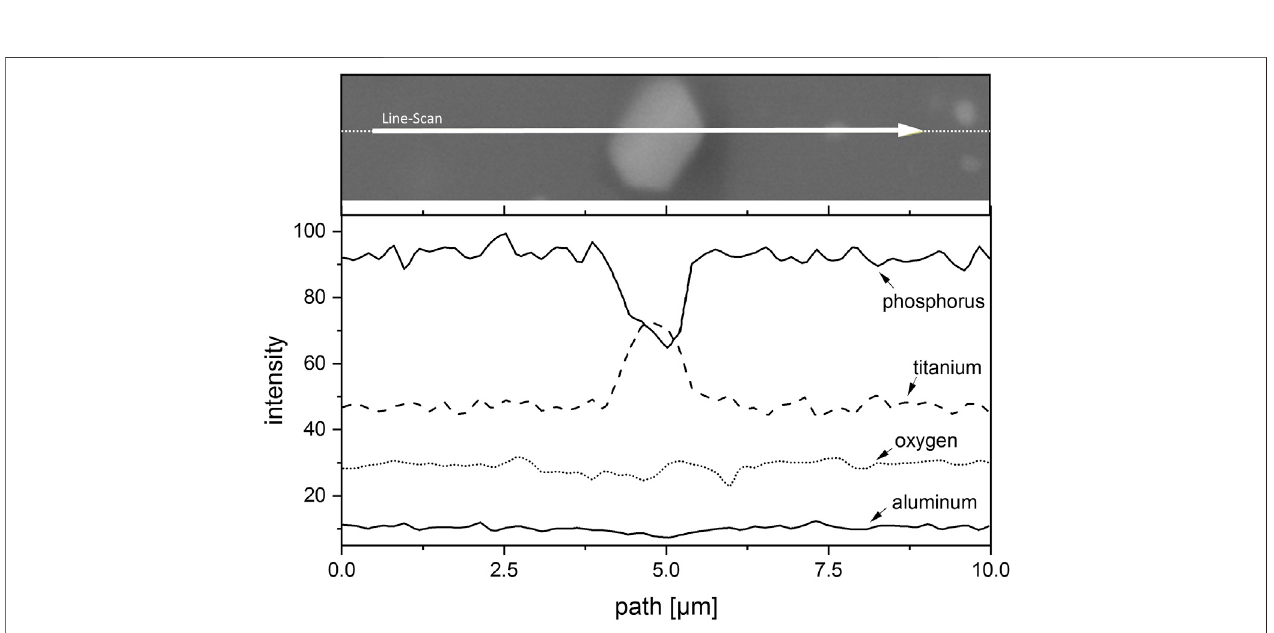
FIGURE7| EDX-line-scanofabrightsecondphaseparticleinthestructureofthesinteredLATP( − 11.25 wt%)sample.Asigni fi cantincreasecanbeclearlyseenin titanium intensity at the position of the bright region, which indicates that the second phase is highly possible to be TiO 2 .